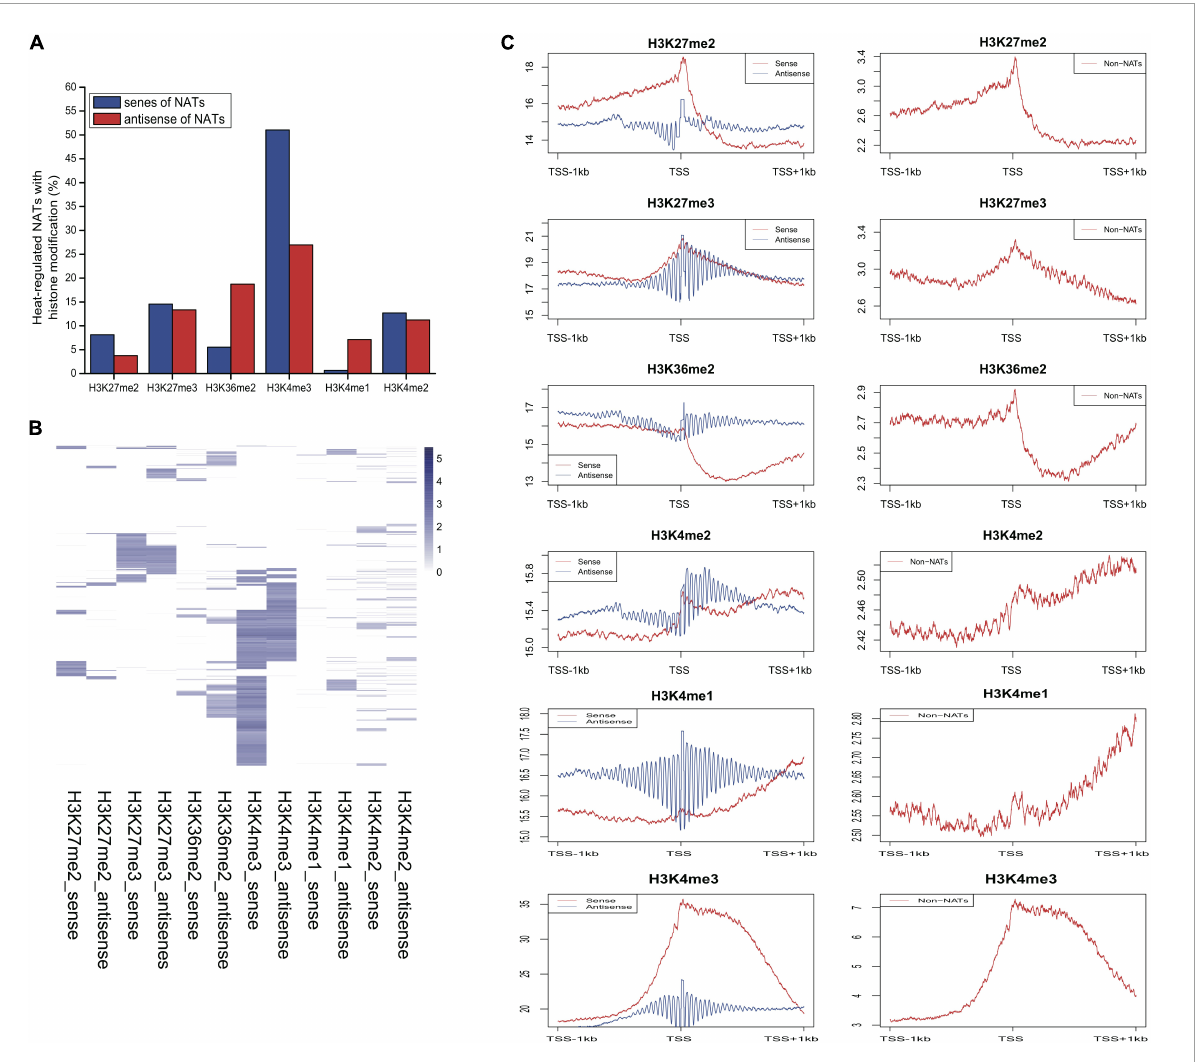
FIGURE5 Histone modifications associated with NAT pairs. (A) Associated of six different histone modifications for heat-regulated NAT genes. (B) Heatmap of histone modification levels for genes of NATs. (C) The degree of six different histone markers around transcription start sites (TSS) of NAT